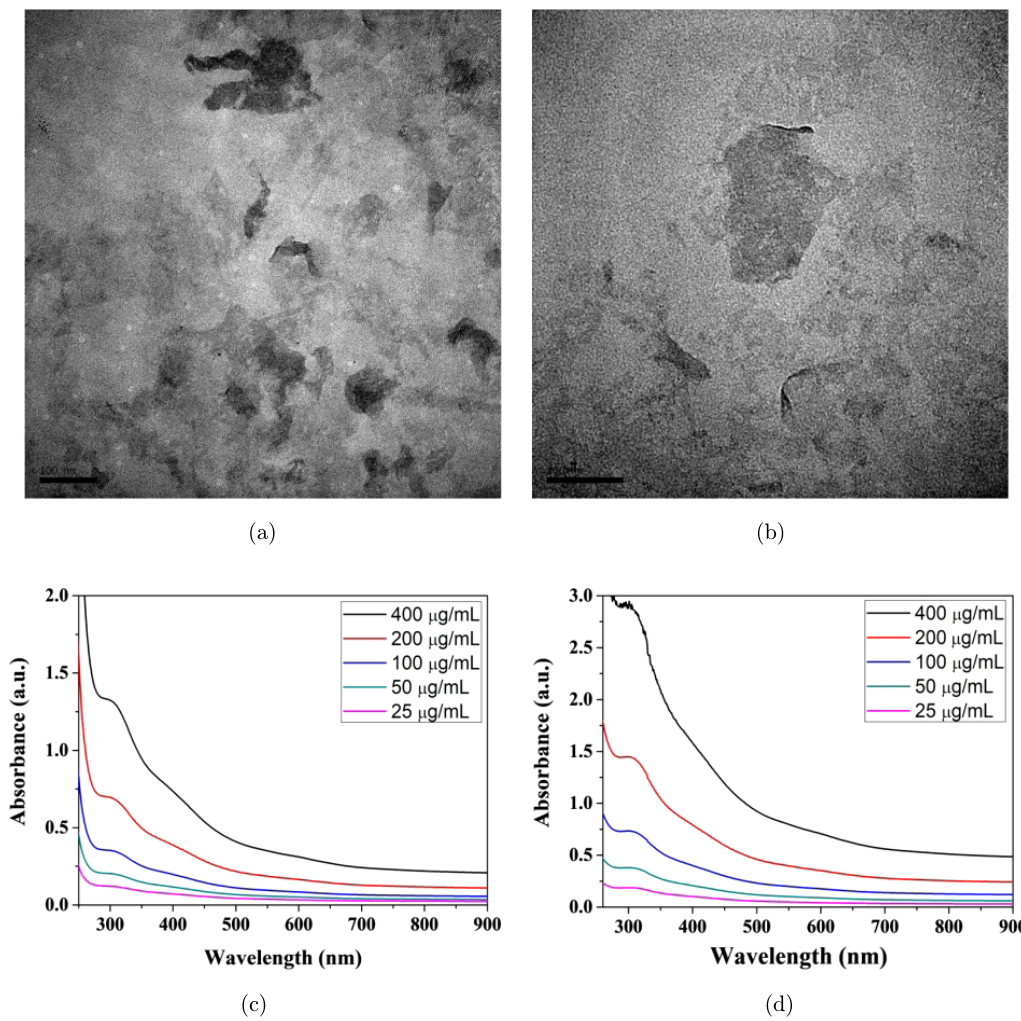
Fig. 1. (a) – (b) TEM images of MoS 2 single-layer nanosheets (a) and few-layer nanosheets (b), respectively. Scalebar: 100 nm. (c) and (d) Absorbance spectra of MoS 2 SL (c) and FL (d) nanosheets with the gradient concentrations,